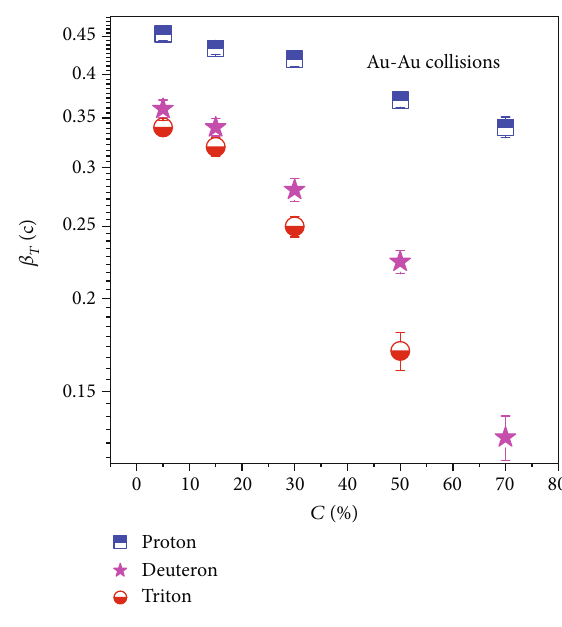
Figure 3: The dependence of β